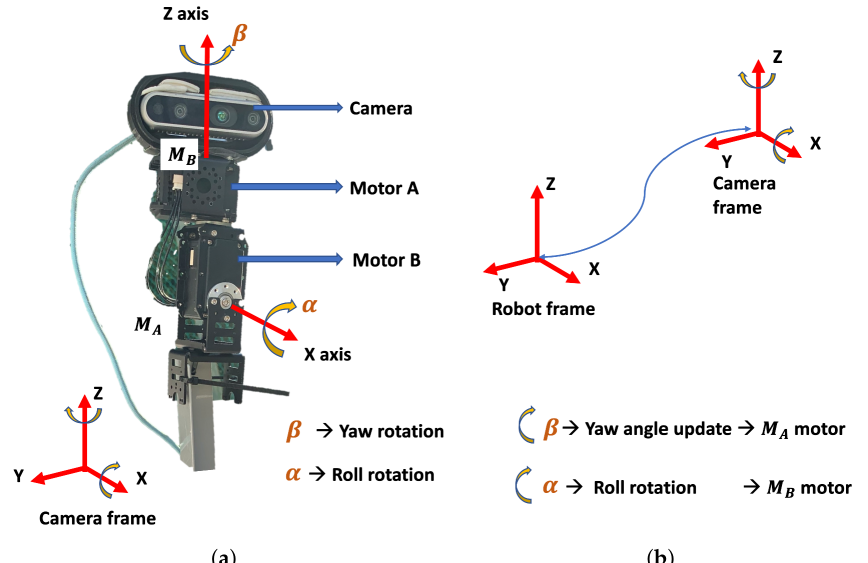
Figure 7. Pan-tilt mechanism. ( a ) Pan tilt camera setup; ( b ) Frames of reference